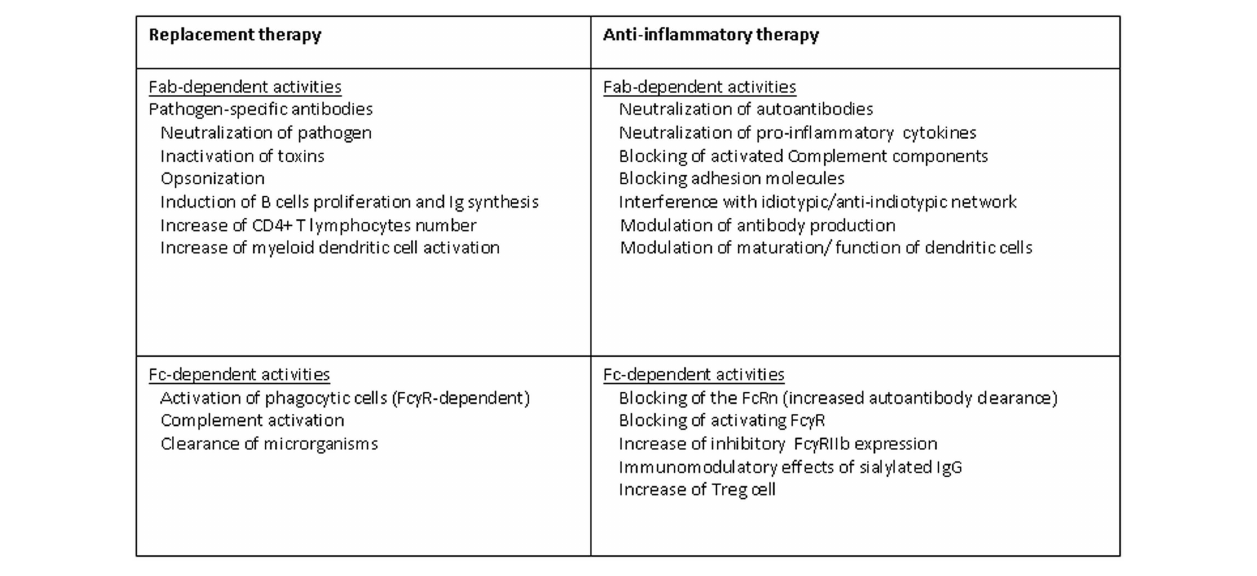
FIGURE 1 | Mechanisms of action of IVIg in PID